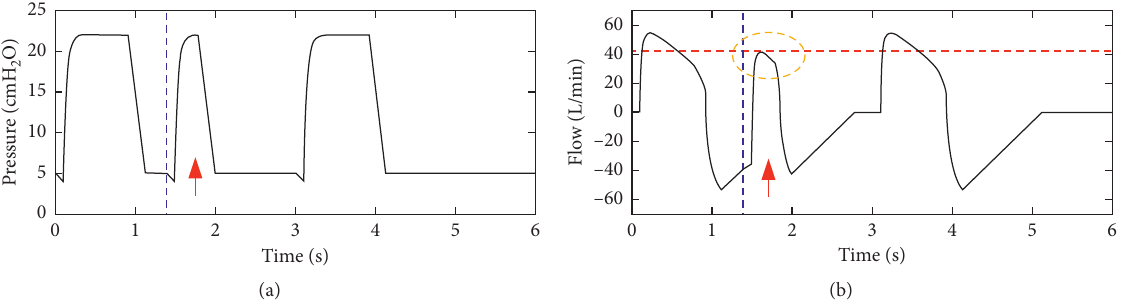
Figure 8: Ventilator waveforms of autotriggering.